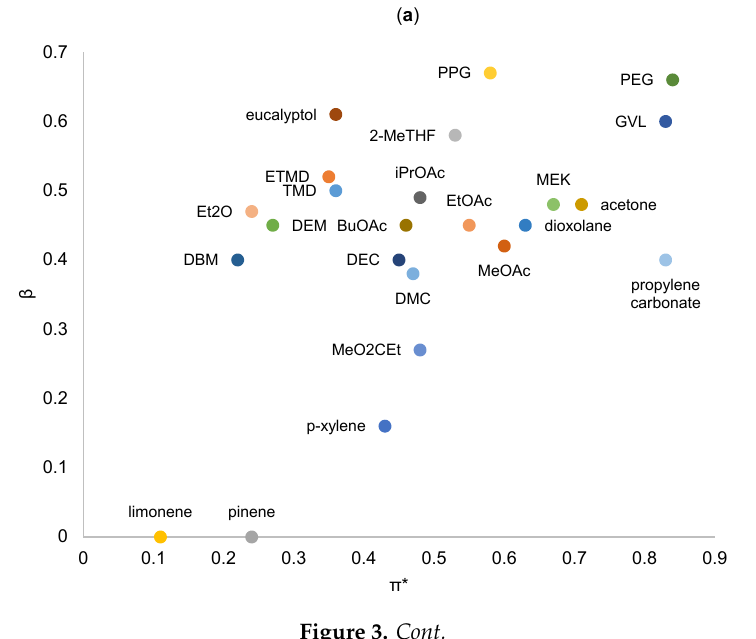
Figure 3. Cont. Figure 3.